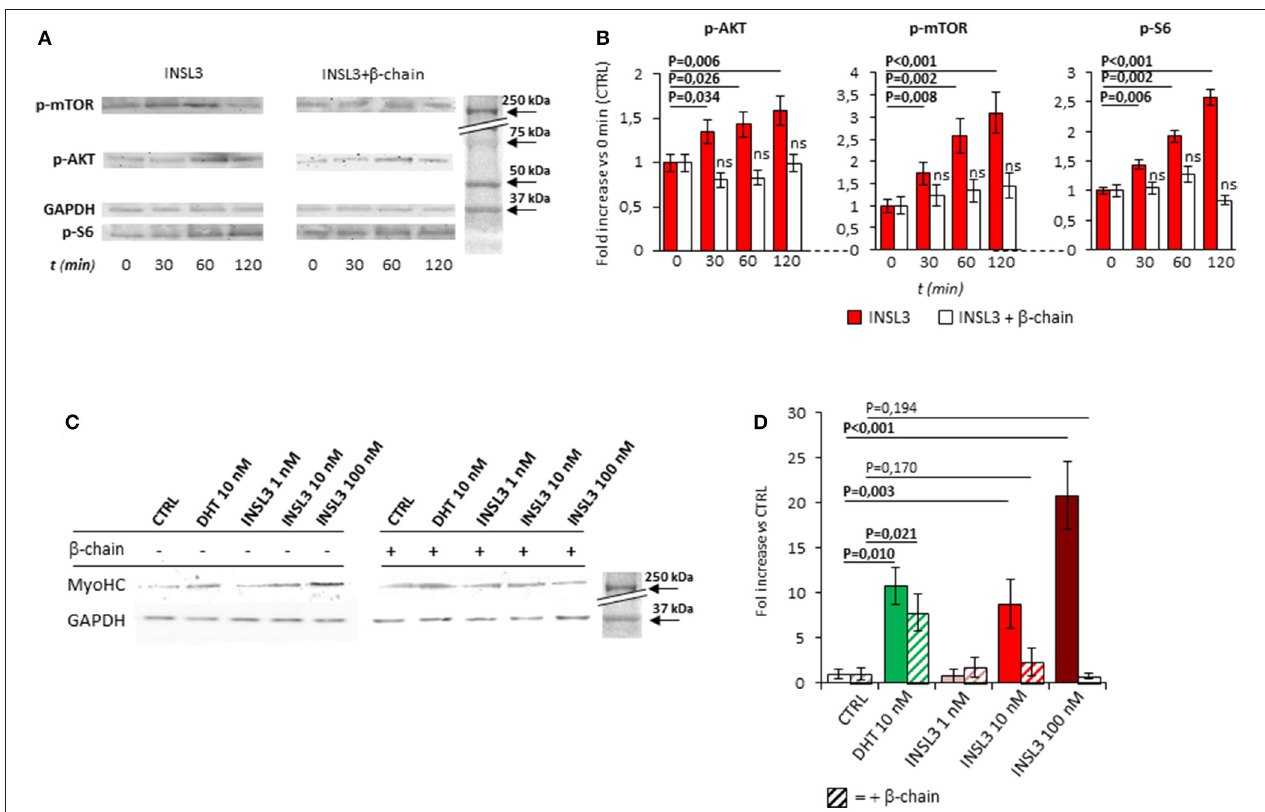
FIGURE 2 | (A) Time-course activation of the downstream AKT/mTOR/S6 phosphorylation, in mature myotubes differentiated from C2C12 cells, up-to 120min after stimulation with INSL3 10nM, in absence or presence of INSL3- β chain dimer ( β -chain, 20nM) as antagonist of RXFP2 receptor. The signaling pathway activation was monitored by western blot, whose representative results are given. Analysis of band density (B) , normalized on GAPDH as loading control, are reported as fold increase compared to basal (CTRL). (C) Effect of INSL3 stimulation on Myosin-Heavy Chain (MyHC) protein expression in mature myotubes. C2C12 cells were cultured in differentiation medium containing INSL3 at concentration ranging from 1 to 100nM, in presence or absence of β -chain. Dihydrotestosterone (DHT) 10nM was used as reference trophic factor. Protein expression was monitored by western blot, whose representative results are given. Analysis of band density (D) , normalized on GAPDH as loading control, are reported as fold increase compared to unstimulated cells (CTRL). Data are reported as mean values ± standard error of the mean of three independent experiments. Significance: P -values between compared conditions are reported. Significant differences ( P < 0.05) are highlighted in bold. Not significant differences in samples co-incubated with INSL3- β chain are marked ns.